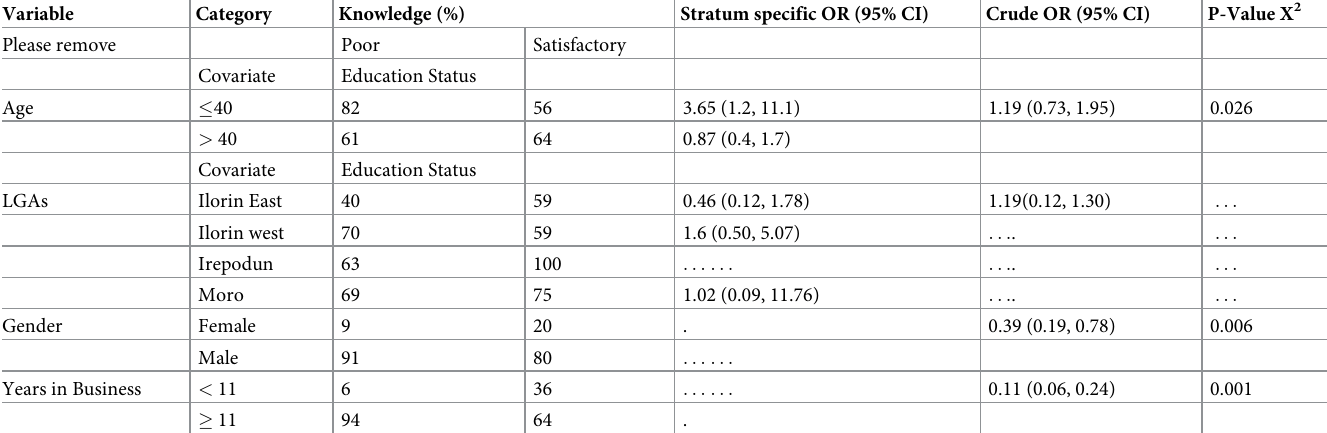
Table 4. Multivariate analysis of the Association between socio-demographic characteristics and knowledge of respondents on antibiotic residues. Variable Category